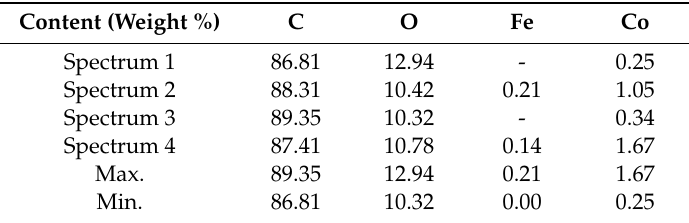
Table 1. Energy dispersive X-ray spectroscopy image of ground and polished PCD surface, also 5 µ m class.